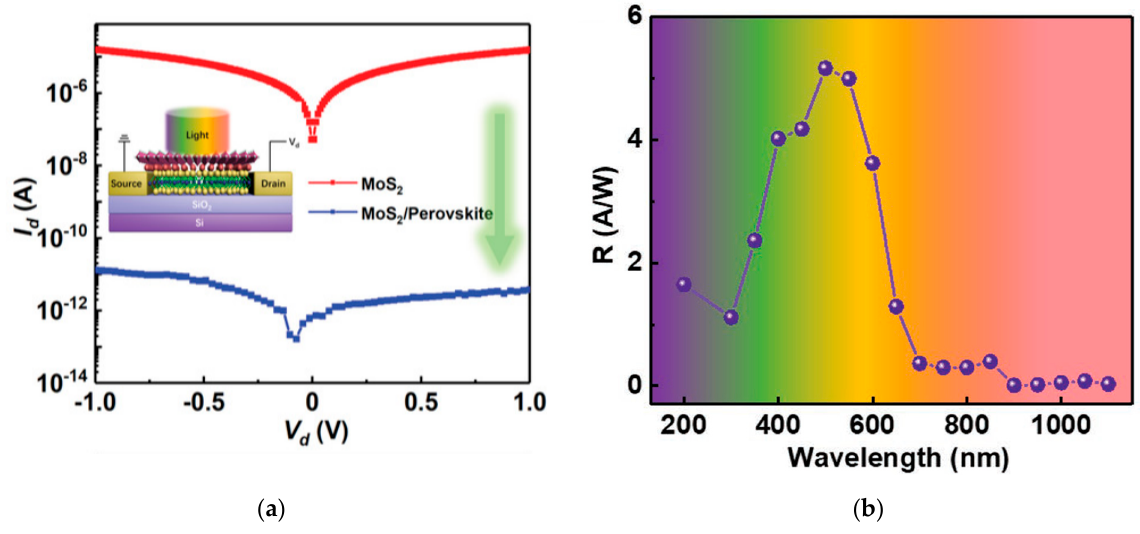
Figure 23. ( a ) Dark current comparison between pristine MoS 2 and MoS 2 passivated with (PEA) 2 PbI 4 ; ( b ) Responsivity of the device with respect to the incident wavelength for a UV-vis-NIR spectrum. Reprinted with permission from ref. [28]. © 2020, John Wiley and Sons.